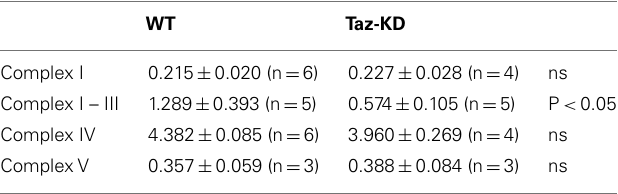
Table 1 | Enzymatic activities of mitochondrial respiratory chain complexes inWT andTaz-KD mitochondria.